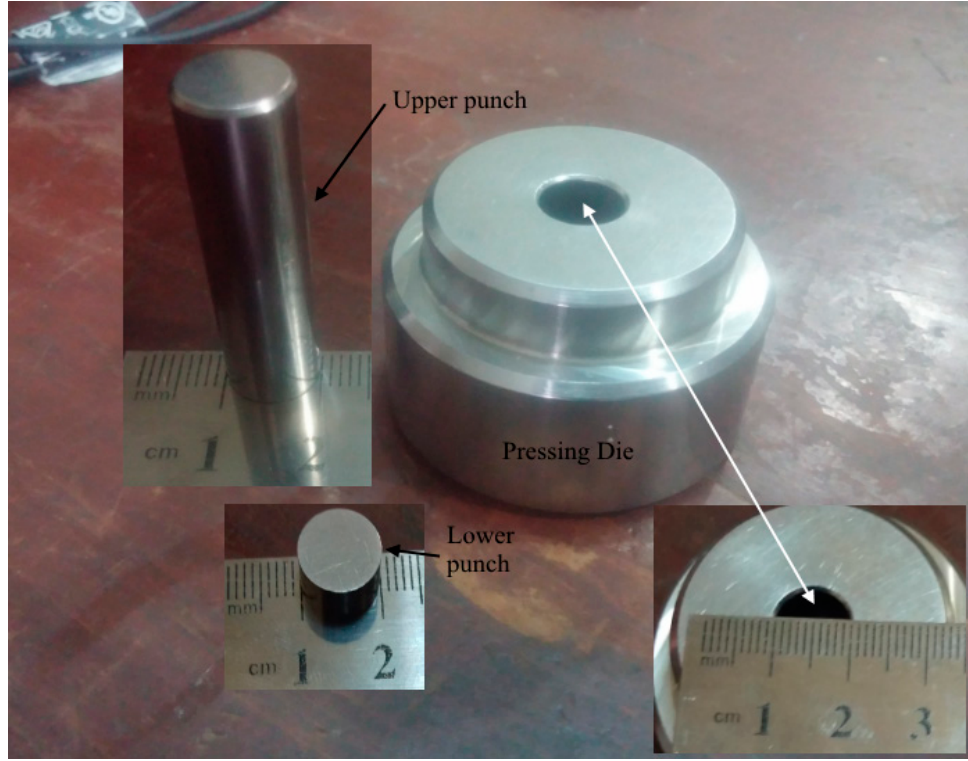
Figure 1. Stainless steel pressing die with inner diameter of 10 mm along with the lower punch for closing the bottom of the die.